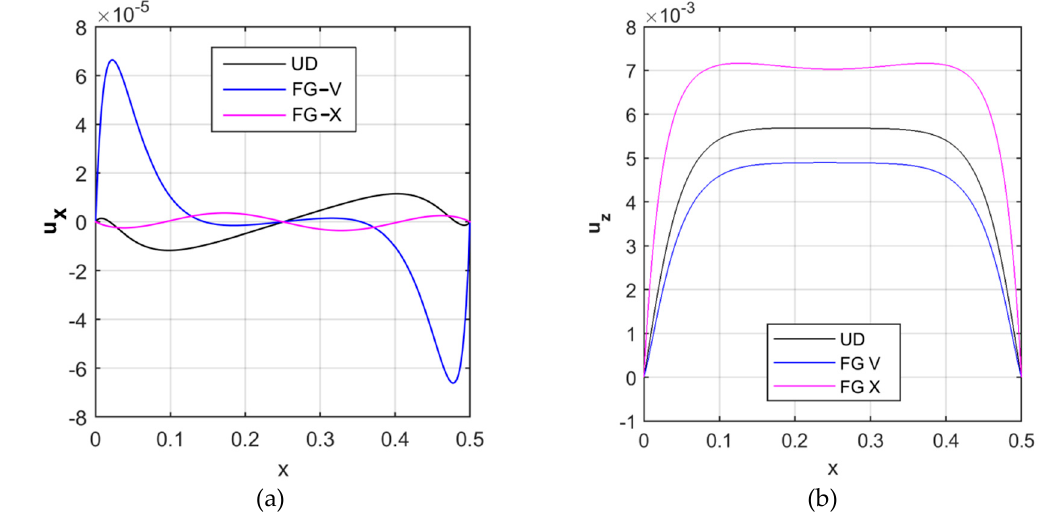
Figure 4. Longitudinal distribution of the axial ( a ) and radial ( b ) displacement components [m], for different reinforcement patterns.